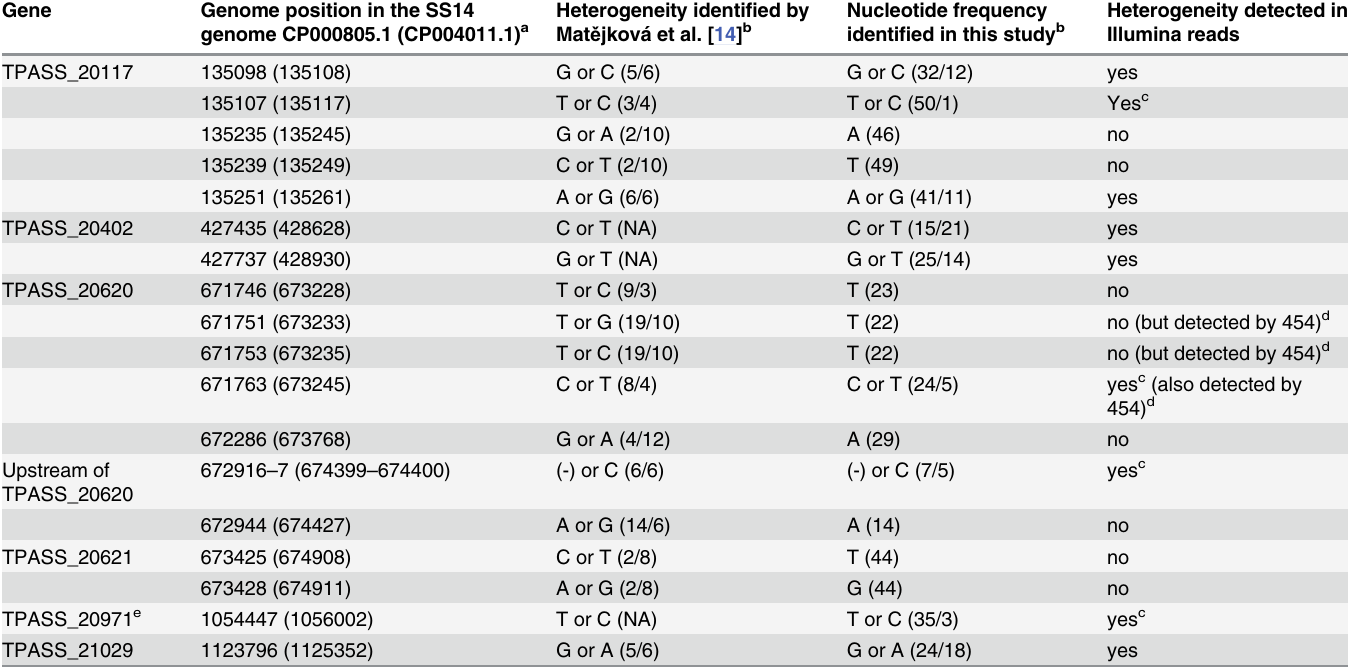
Table 4. Comparison of heterogeneous positions identified in TPA SS14 strain by Mat ě jková et al. [14] and by the automated pipeline used in this